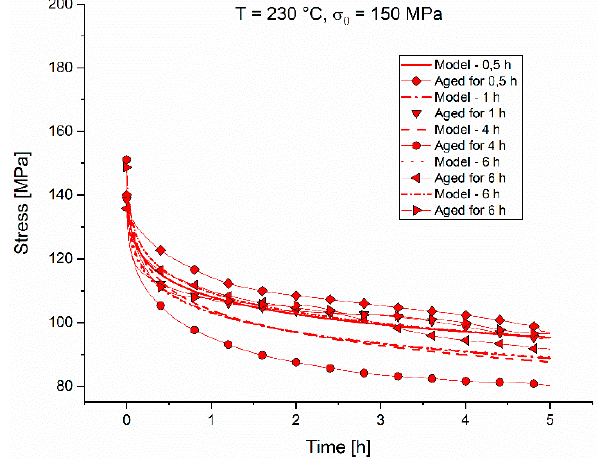
Figure 11. Comparison of experimental and simulated stress relaxation curves tested in aged condition at 230 °C with test stress of 150 MPa.